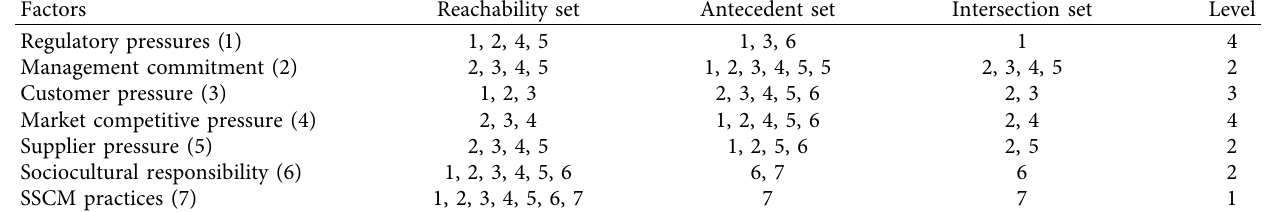
Table 3: Level partitioning.